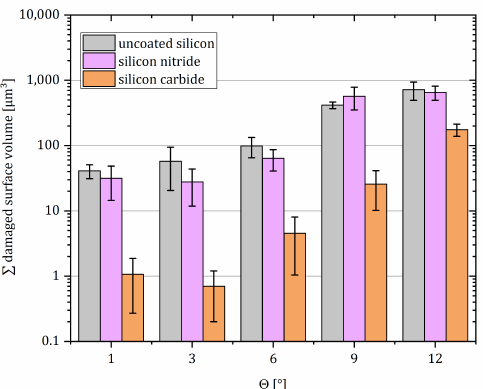
Figure 10. Cumulated surface damage volume in dependence of Θ . Six samples were evaluated for each data point. The error bars represent the standard